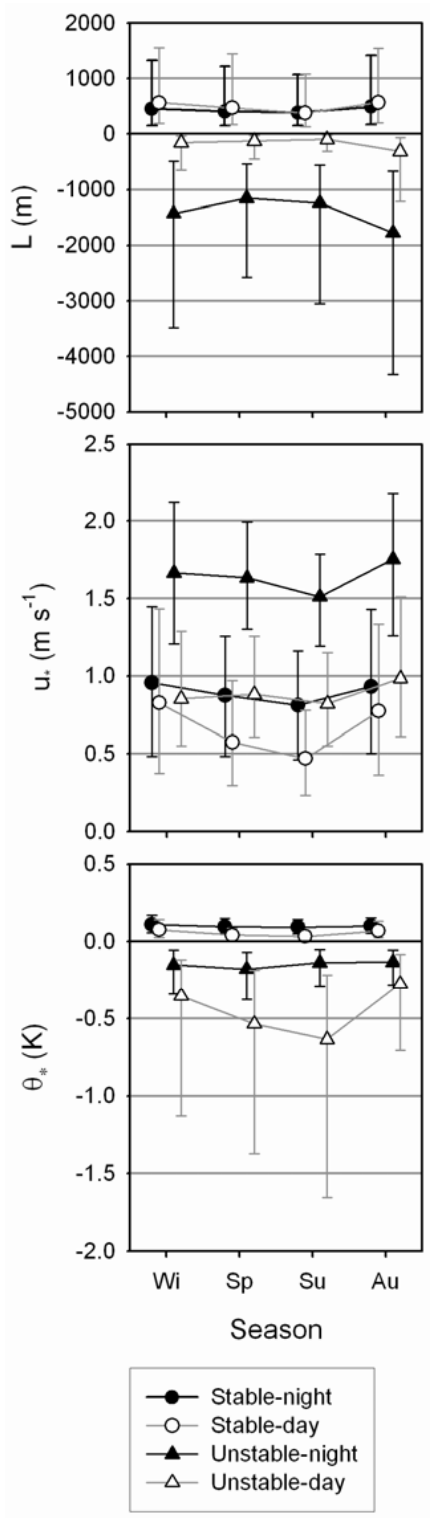
Fig. 5. Seasonal medians of L , u ∗ and θ ∗ calculated during the Figure 5.- Seasonal medians of L , u day and night for stable and unstable situations. Bars show the in- terquartile stable and unstable situations. Bars show the interquartile range.